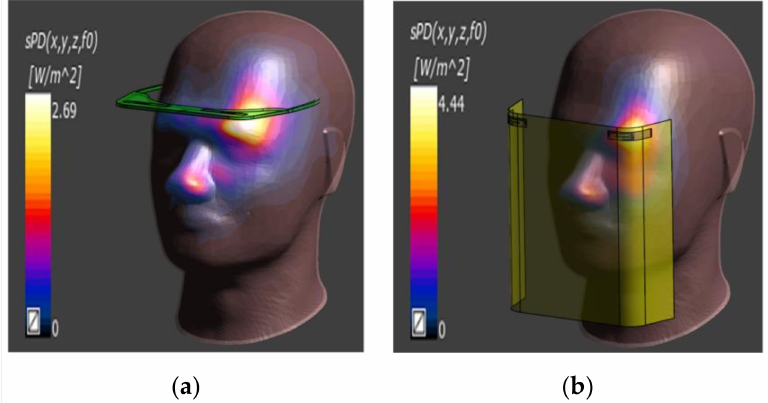
Figure 40. PD simulation results at 6.8 GHz: ( a ) Ant. 1, ( b ) Ant. 3.